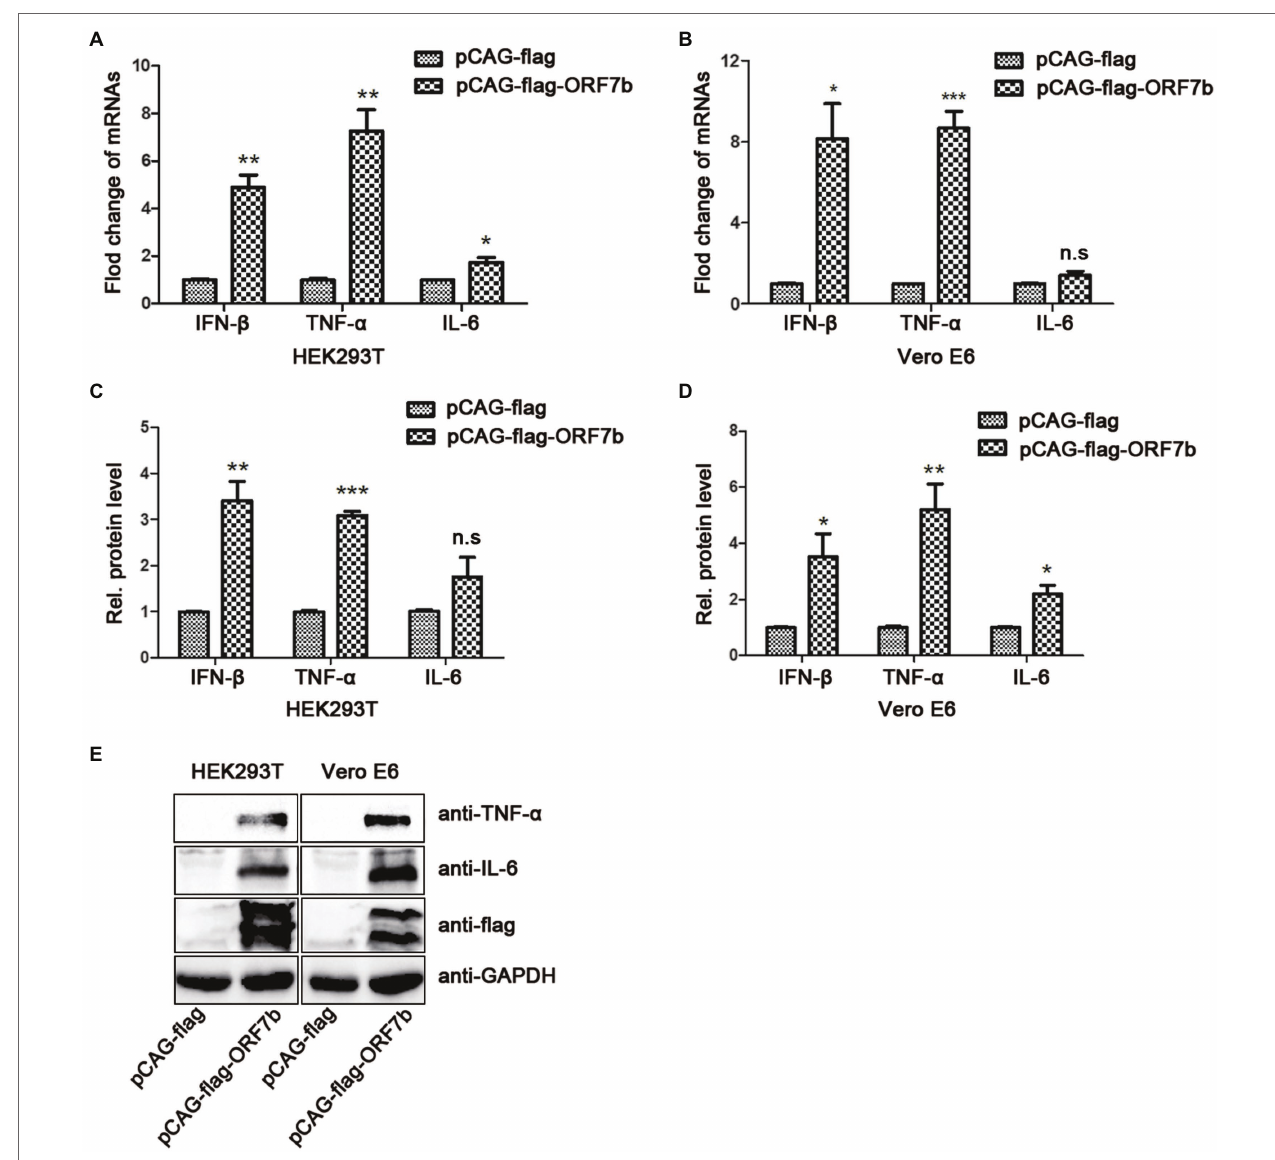
FIGURE 2 | ORF7b increases the expression of tumor necrosis factor (TNF)- α , IL-6, and IFN- β . (A) mRNA levels of IFN- β , TNF- α , and IL-6 in HEK193T cells were determined by reverse transcription-quantitative polymerase chain reaction (QRT-PCR) at 18 h after transfection with pCAG-flag and pCAG-flag-ORF7b. (B) mRNA levels of IFN- β , TNF- α , and IL-6 in Vero E6 cells were determined by QRT-PCR at 18 h after transfection with pCAG-flag and pCAG-flag-ORF7b. (C) Expression of IFN- β , TNF- α , and IL-6 in HEK193T cell-culture supernatants was determined by ELISA at 18 h after transfection with pCAG-flag and pCAG-flag-ORF7b. (D) Expression of IFN- β , TNF- α , and IL-6 in Vero E6 cell-culture supernatants was determined by ELISA at 18 h after transfection with pCAG-flag and pCAG-flag-ORF7b. (E) Protein expression of TNF- α and IL-6 in Vero E6 cells and HEK293T cells was detected by Western blotting at 18 h after transfection with pCAG-flag and pCAG-flag-ORF7b. Data are the mean ± SD, n = 3. *p < 0.05, ** p < 0.01, *** p < 0.001, and n.s means no significant difference compared with the control group (Student’s t